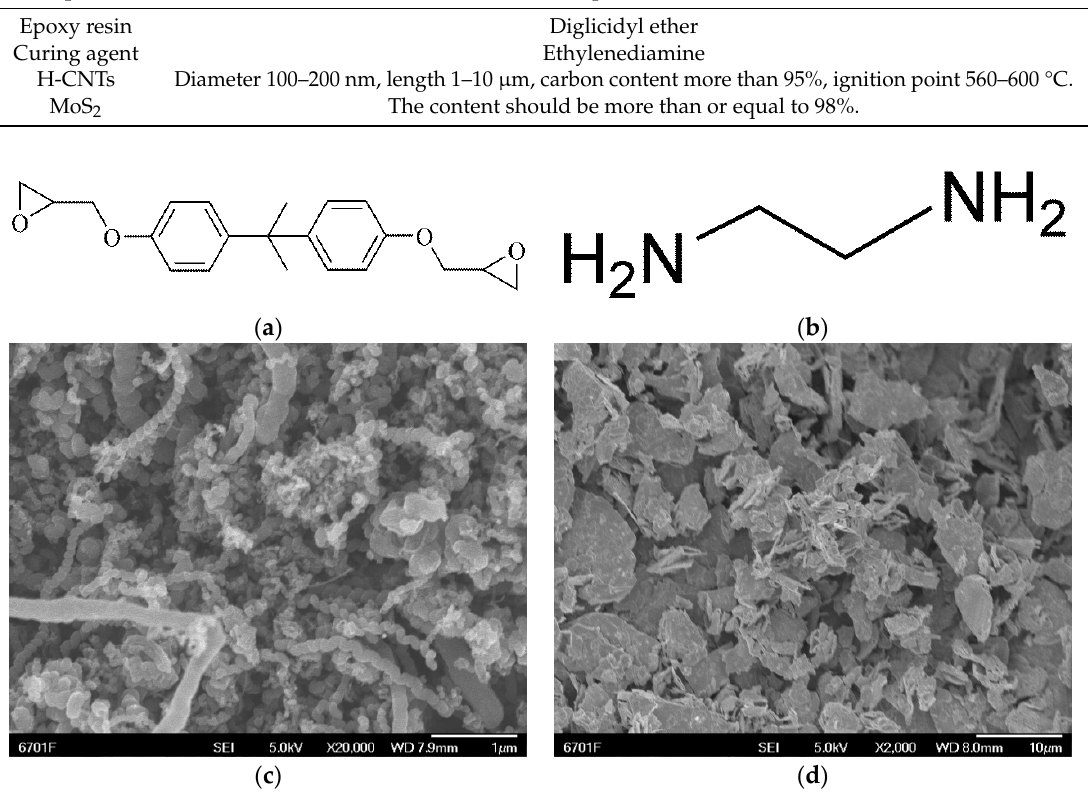
Figure 1. Molecular structure of ( a ) diglicidyl ether, ( b ) ethylenediamine and FESEM images of ( c ) helical carbon nanotubes (H-CNTs), ( d ) molybdenum disulfide (MoS 2